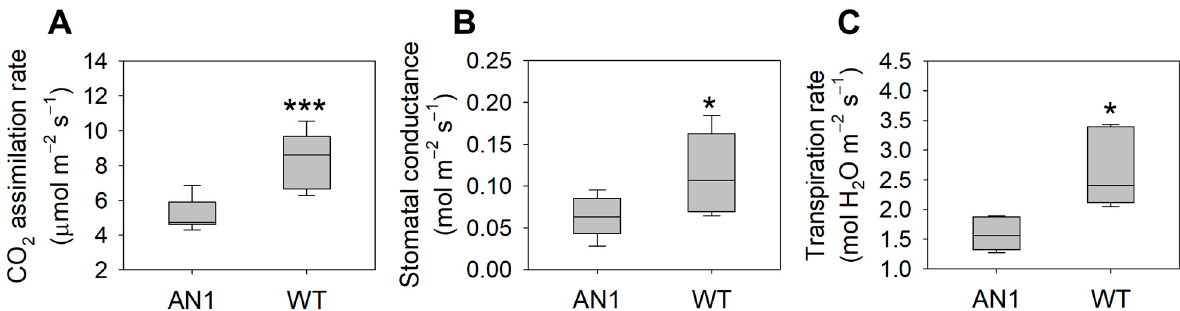
Figure 4. Leaf gas exchanges in AN1 and WT plants. ( A ) CO 2 assimilation rate; ( B ) Stomatal conductance; ( C ) Transpiration rate. Asterisks indicate significant differences according to ANOVA (* p < 0.05; *** p < 0.001).